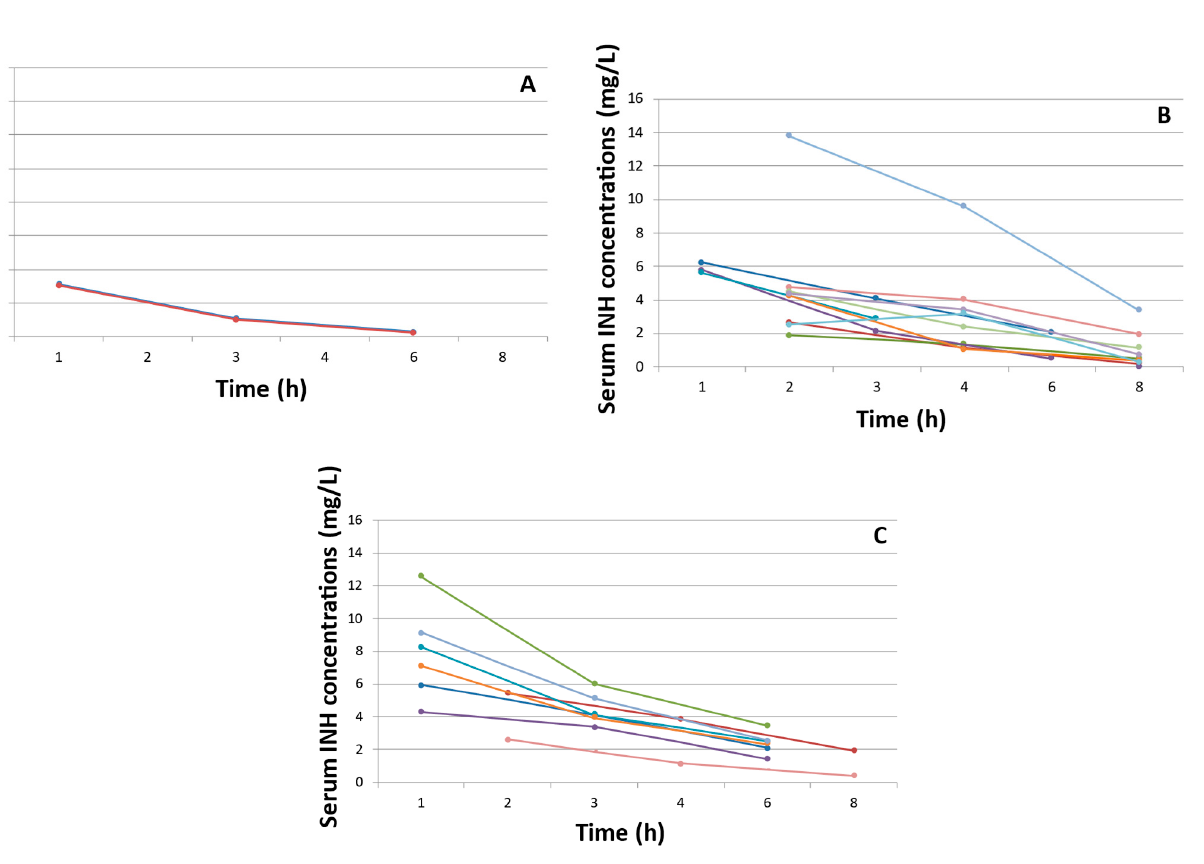
Figure 1. Isoniazid serum concentrations (in mg/L) according to NAT2 genotyping by acetylator type. ( A ) NAT2 homozygous fast genotype; ( B ) NAT2 heterozygous intermediate genotype; and ( C ) NAT2 homozygous slow genotype.